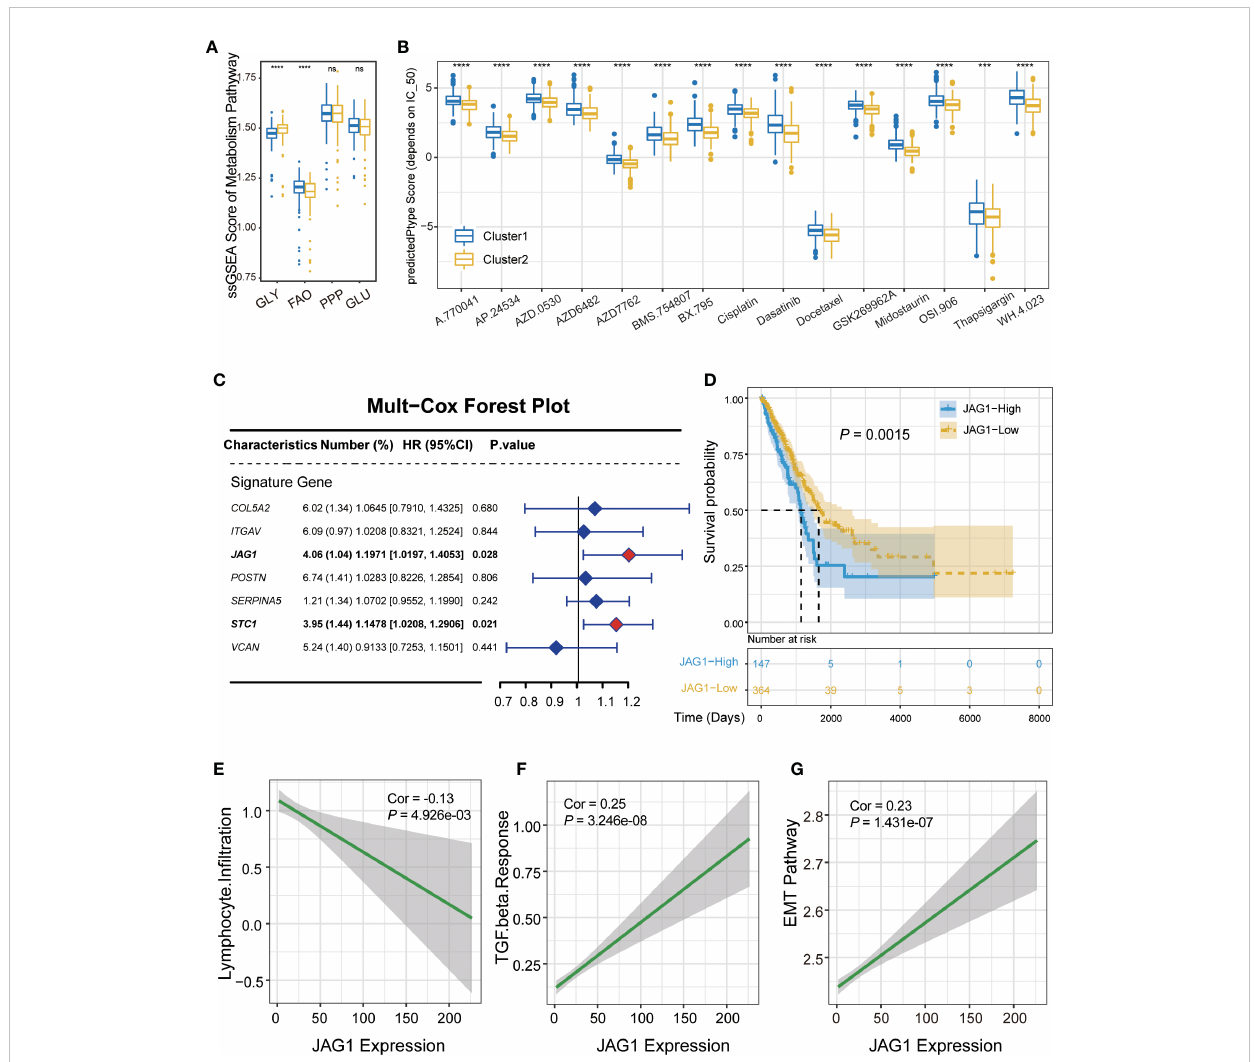
FIGURE 4 Validation of the correlation between JAG1 and immune microenvironment. (A) The boxplot of metabolism pathway activation between AGS1 and AGS2. (B) The boxplot showed IC50 value representing drug responds. (C) The forest plot of multivariate Cox regression. (D) The Kaplan – Meier plot of the comparison in the overall survival between AGS1 and AGS2. (E-G) The scatter plot of JAG1 expression and (E) lymphocyte in fi ltration, (F) TGF- b response, and EMT pathway. *, P < 0.05; **, P < 0.01; ***, P < 0.001; ****, P < 0.0001. ns represents p value is not signi fi